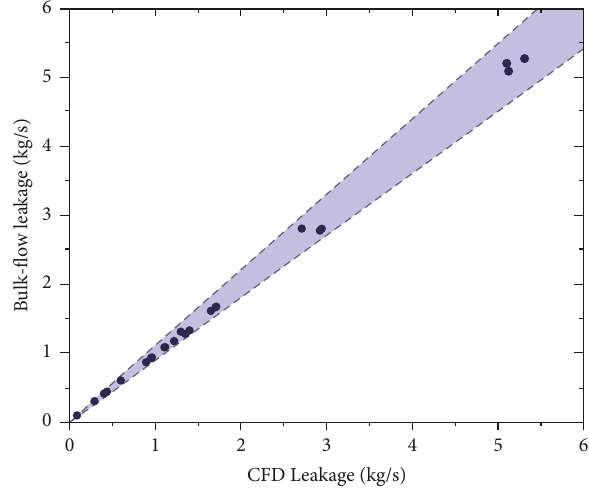
Figure 17: Nomenclature of the geometric